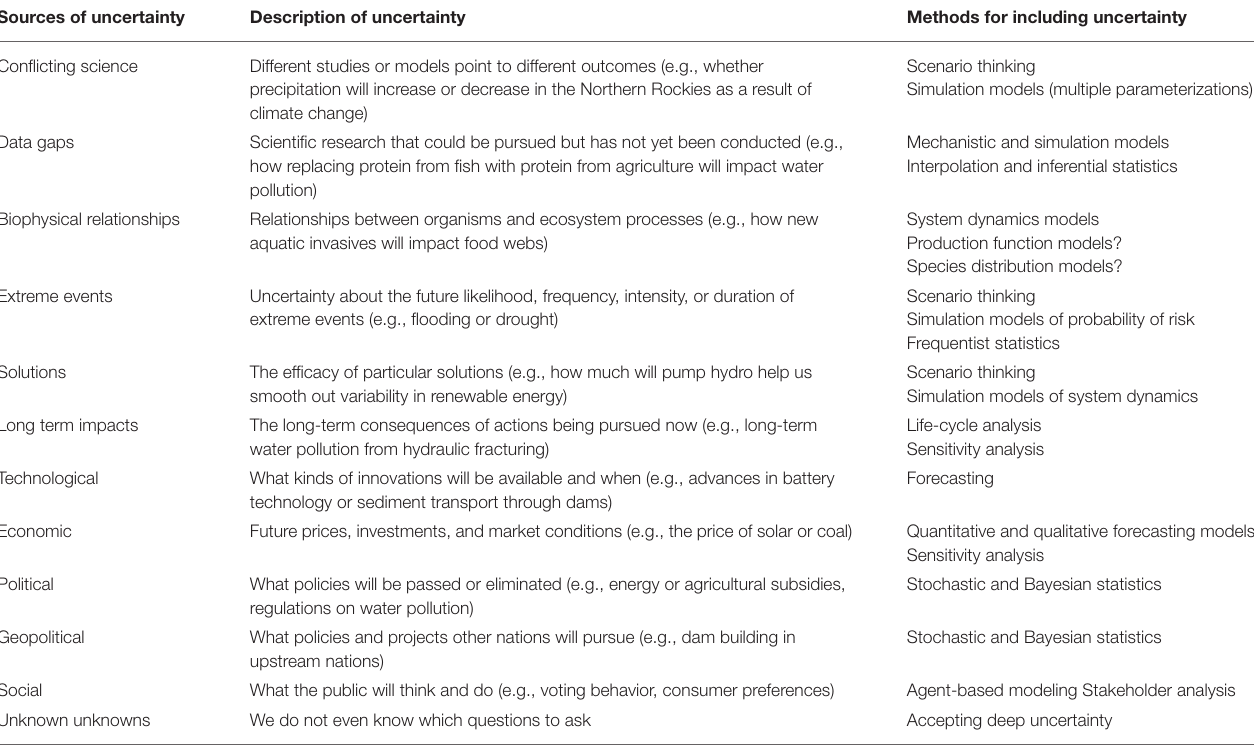
TABLE 1 | A typology of sources of uncertainties and methods to include uncertainty in water-energy-food nexus research and application. Sources of